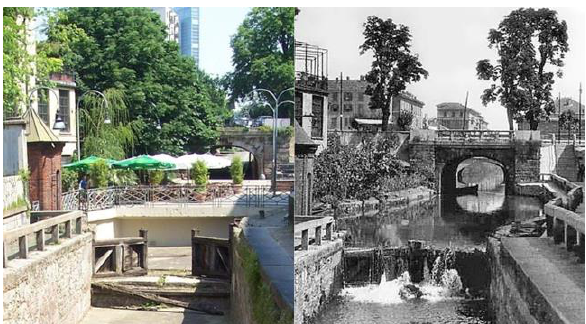
Figure 6 . The Conca di Viarenna, Milan. Italy: (a) today; (b) historical